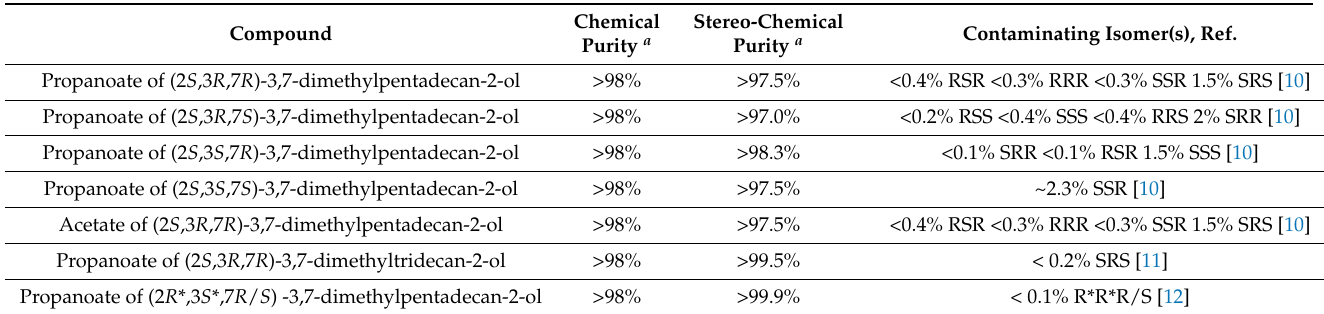
Table 1. Chemicals used in the field tests with references to their purities and preparation. Compound